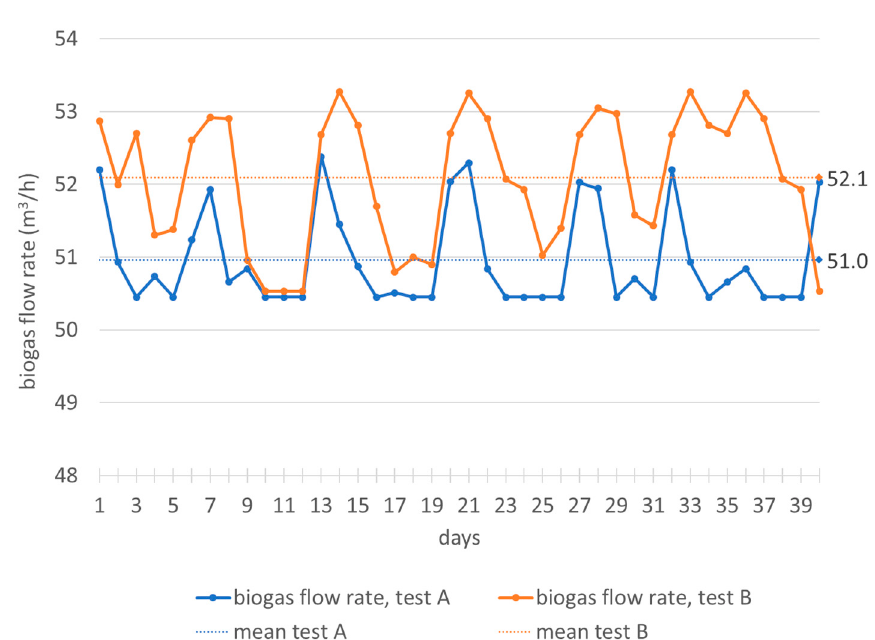
Figure 4. Monitoring of biogas flow rate in the digesters during the hydraulic retention time.